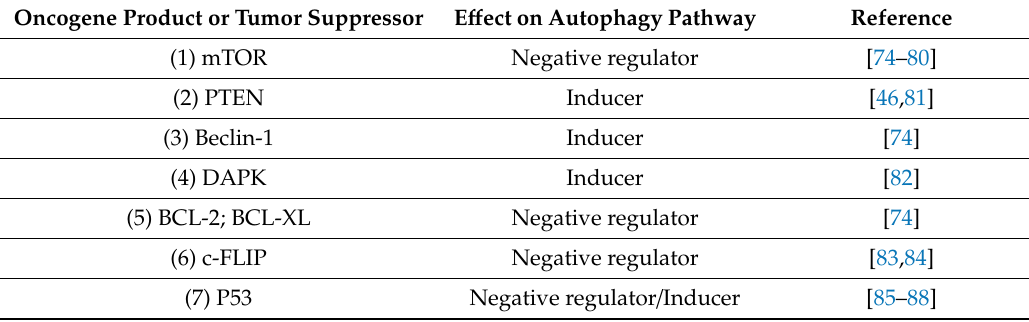
Table 1. List of oncogene products and tumor suppressors that control the autophagy pathway. Oncogene Product or Tumor Suppressor E ff ect on Autophagy Pathway